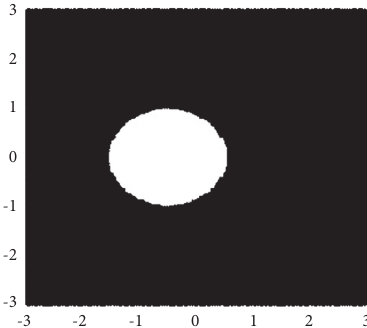
Figure 5: The Julia set of P ( z ) � z 2 + z + c is connected where 2 (0.3 ∈ GM( P )). 2 ( z ) . 2